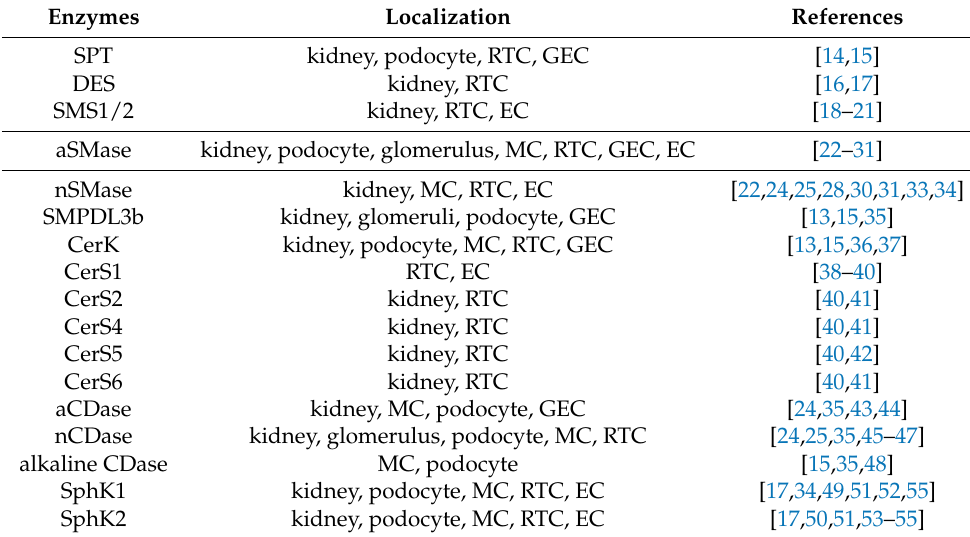
Table 1. Localization of enzymes that regulate formation of ceramide and sphingosine-1-phosphate in